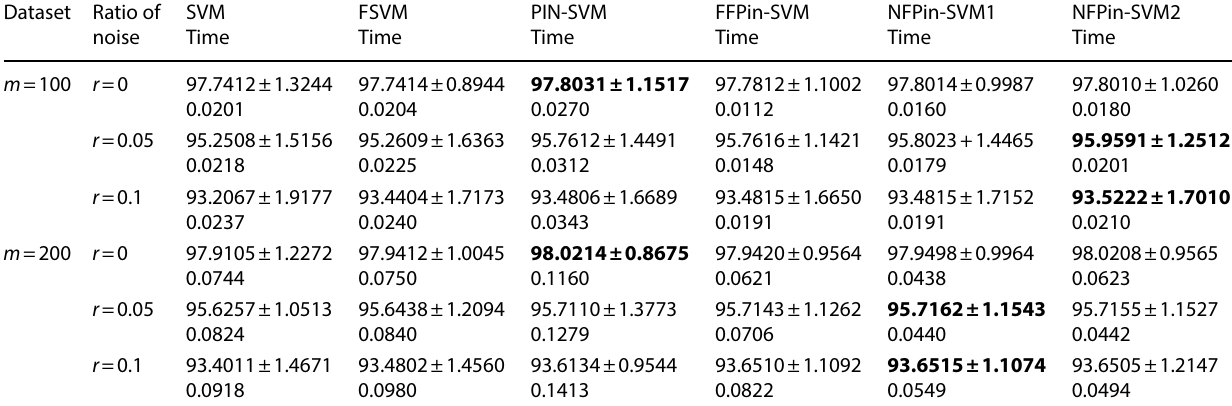
Table 1 The performance comparison of our proposed methods FPin-SVM, NPin-SVM1, and NPin-SVM2 with Pin-SVM, FSVM, and SVM on synthetic datasets with different noises. Time is for training in seconds Dataset Ratio of noise